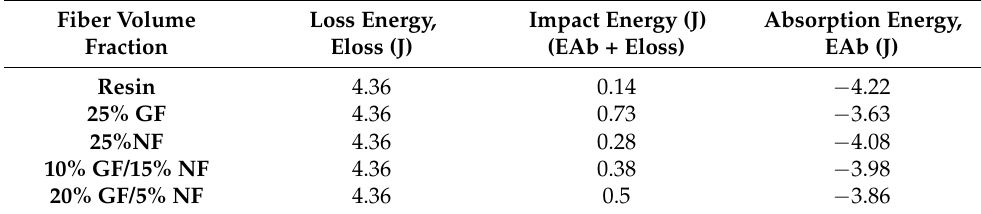
Table 5. Measured energies at impact testing vs. date palm fibers percentage.